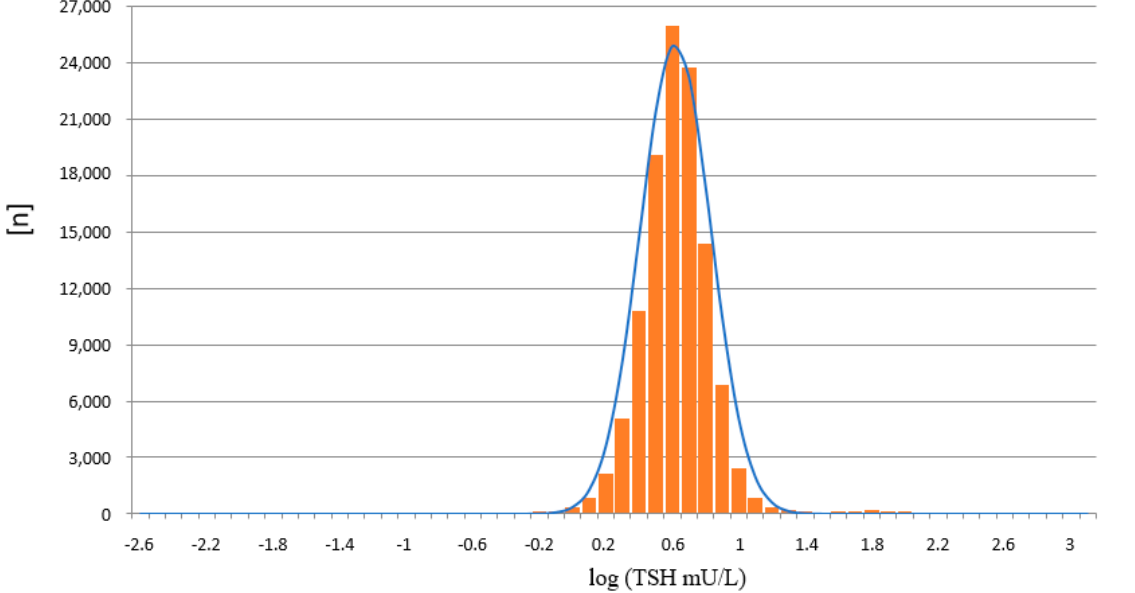
Figure 8. Distribution of TSH values measured on the LDx/NS2400 platform, after logarithmic transformation ( n = 116,260). In addition, 36 samples from EQA schemes were measured on the LDx/NS2400 platform. In total, 21 samples were from RfB, 11 from UK-NEQAS and 4 from CDC (Table 3). QC samples were kept at − 18 ◦ C in sealed plastic bags with desiccant, upon arrival in the